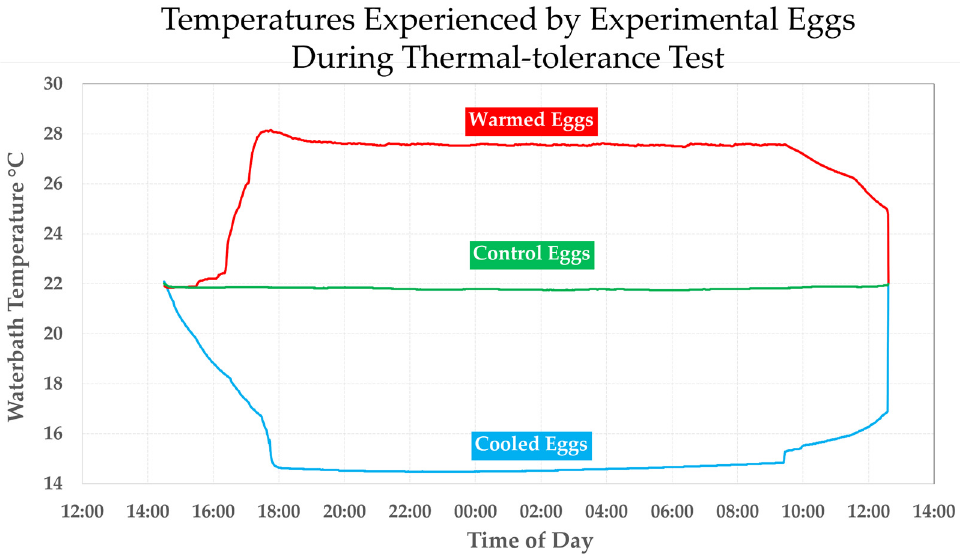
Figure 7. Record of the water temperatures experienced by the three experimental groups of Huff- manela eggs prior to feeding eggs to experimental amphipods. Huffmanela eggs prior to feeding eggs to experimental